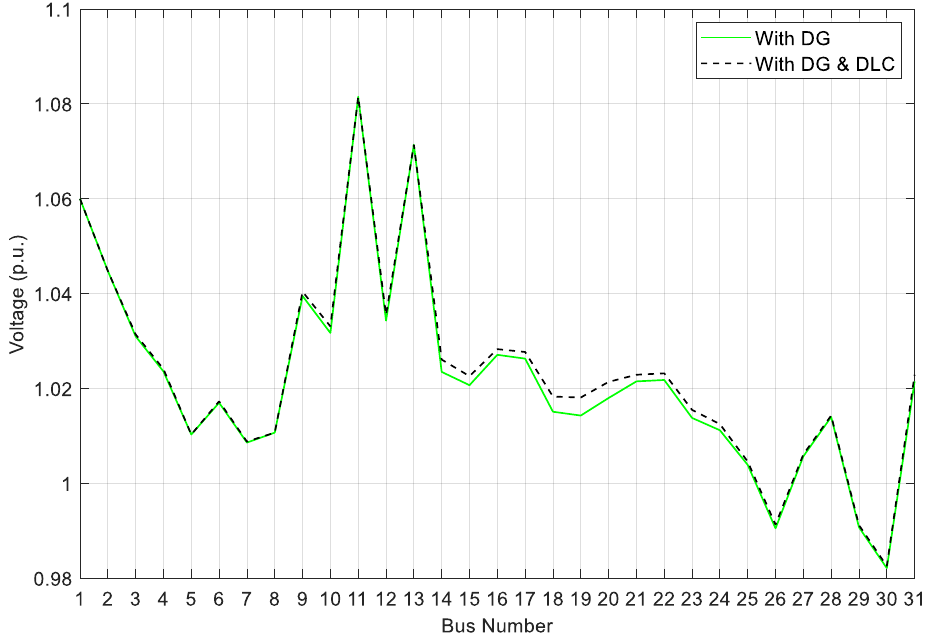
/ without DLC in the presence of DG.